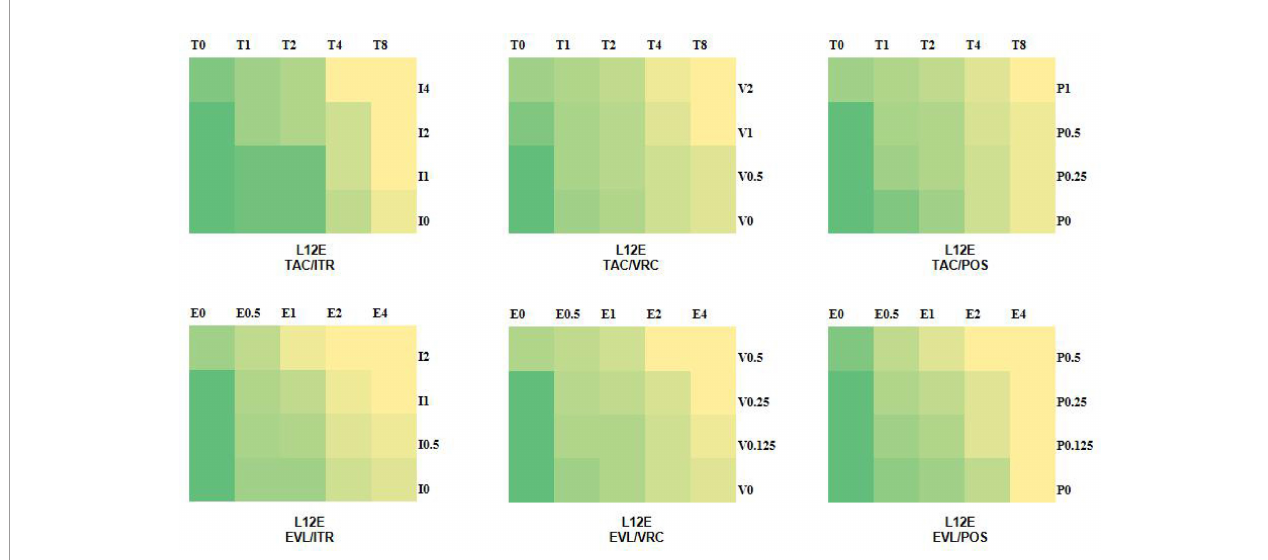
FIGURE 1 | Schematic diagram of drug sensitivity. The colors of green to yellow represent the amount of fungal growth in the various drug combination concentrations. Green indicates good fungal growth, yellow indicates poor fungal growth. T, tacrolimus; E, everolimus; I, itraconazole; V, voriconazole; P, posaconazole; and the number after the letter represents the concentration